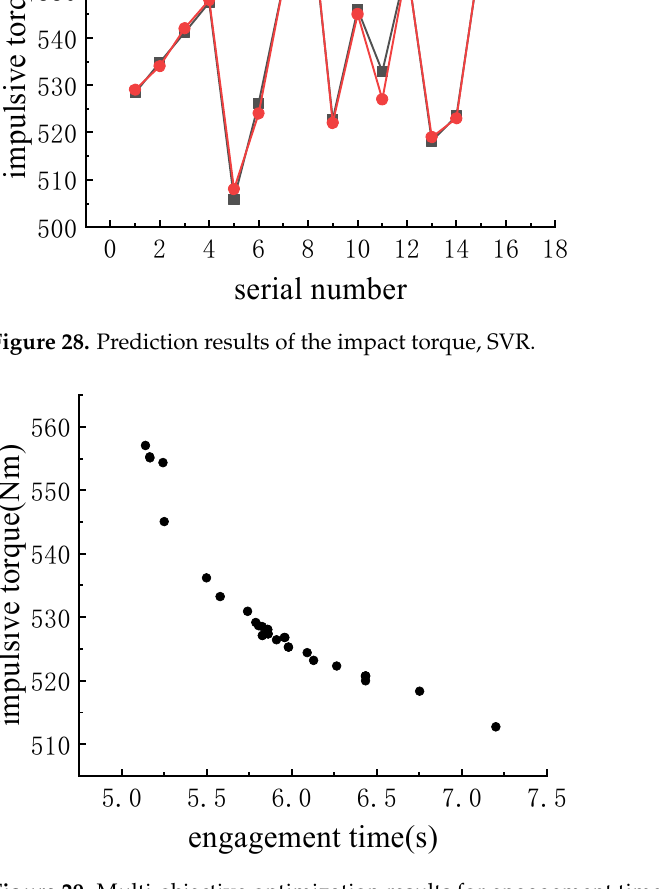
Figure 28. Prediction results of the impact torque, SVR.